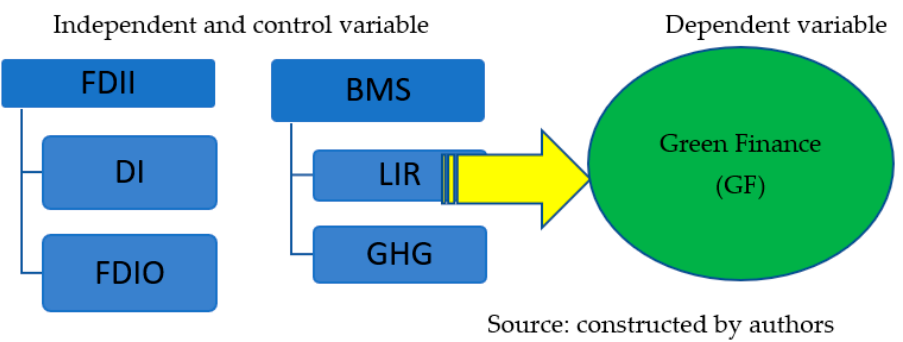
Figure 1. Conceptual framework of the study. NB: BMS = Broad money supply. LIR = lending interest rate. FDIO = outward foreign direct investment. FDII = inward foreign direct investment. DI = domestic investment. GHG = greenhouse gas.